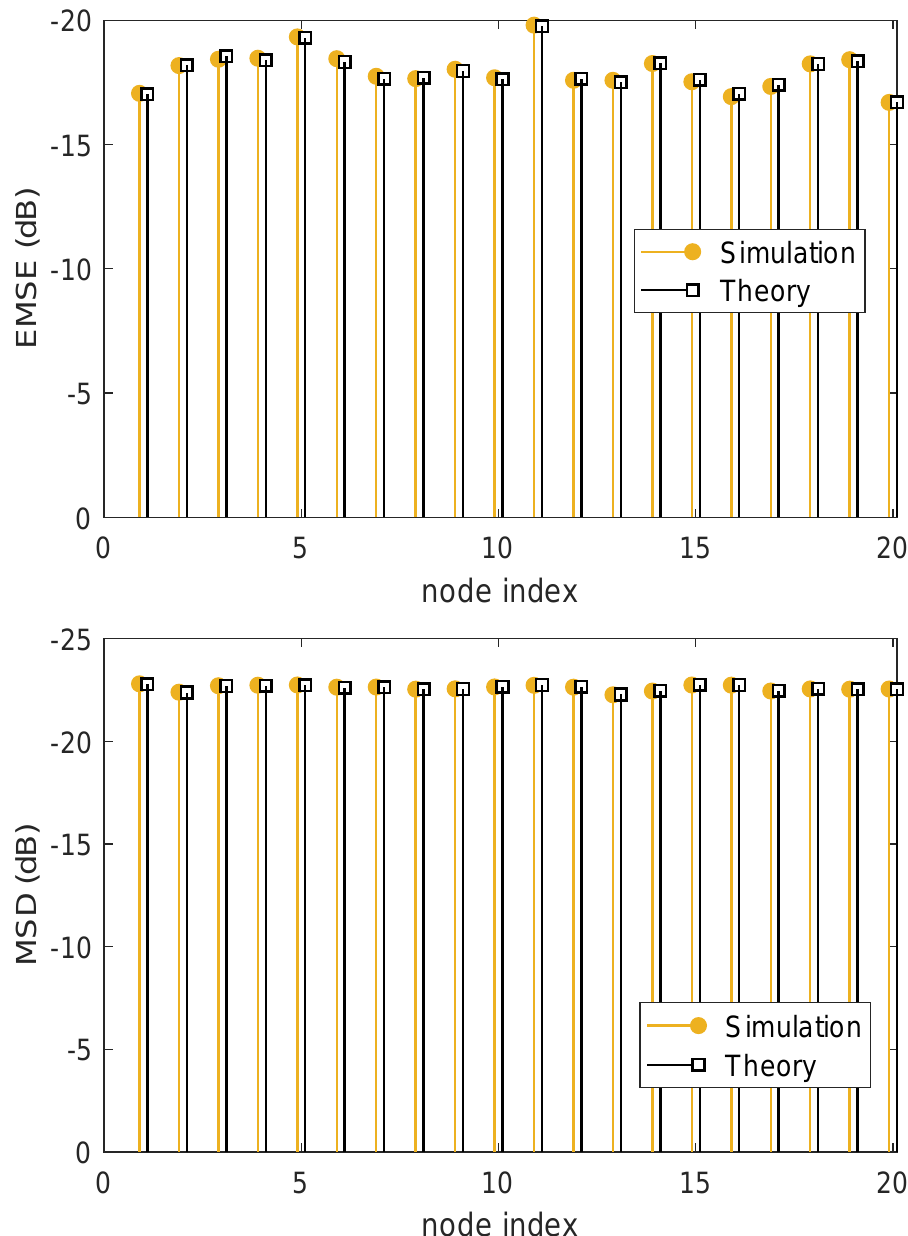
Figure 5. Theoretical and experimental steady-state MSD and EMSE at each node. Figure 6 shows the modes of convergence for the case R u = I L and K = 10, for Figure 6, it can be observed that, regardless of the values of step-size parameter, the full-update ILMS algorithm is always faster than the CD-ILMS